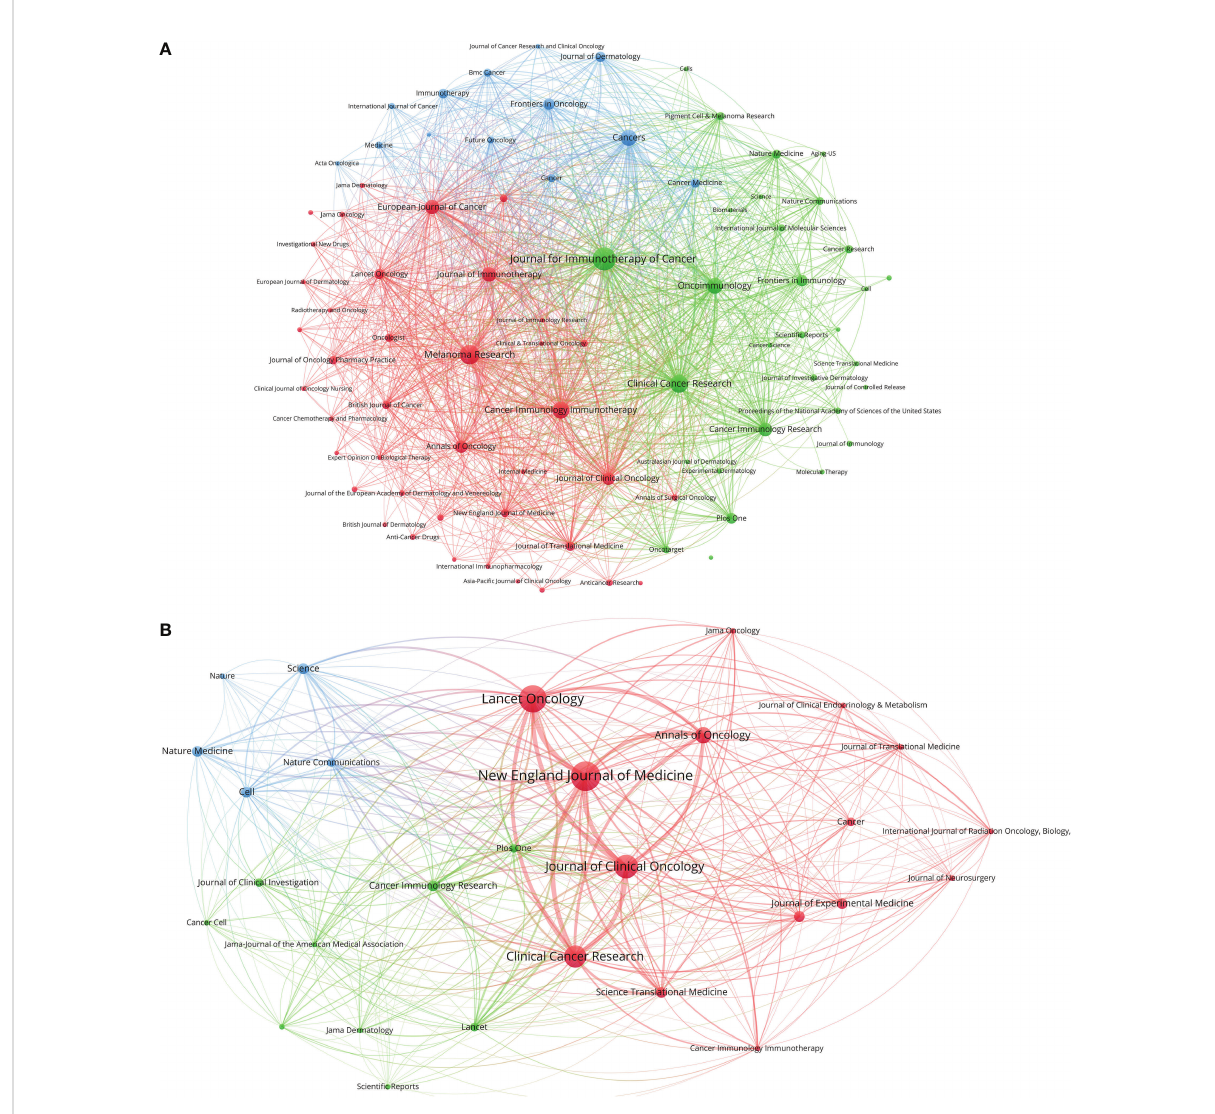
FIGURE 2 (A) Bibliographic coupling of journals with at least fi ve papers related to melanoma immunotherapy. (B) Bibliographic coupling of journals with top-papers related to melanoma immunotherapy. The circle size represents the number of papers. The breadth of the curves represents the connection strength. The journals in the same color are of similar research